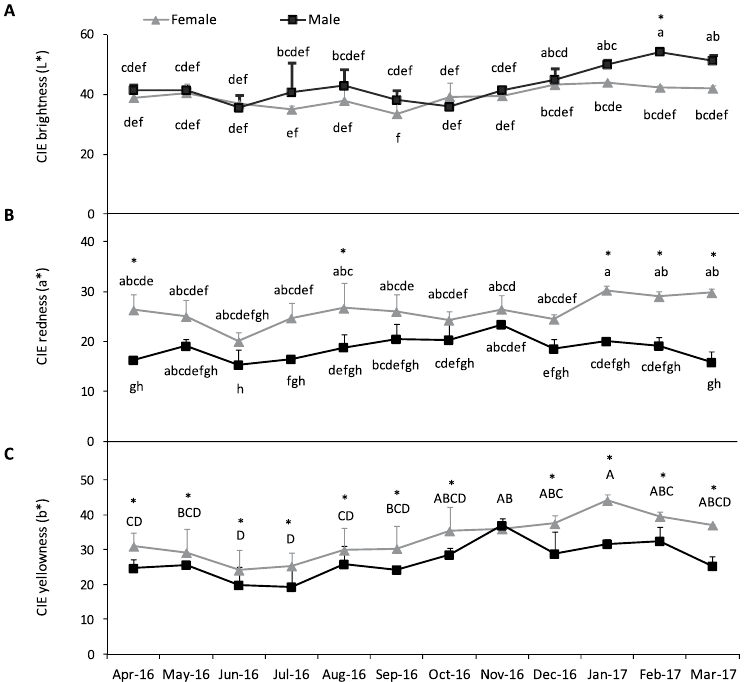
Figure 3. Colour parameters ( A ) lightness, L * ( B ) redness, a * and ( C ) yellowness, b * measured instrumentally in gonads of P . lividus (ovary and testis) over a 13-month period. Values are mean ± standard deviation; per month the 18 individuals were pooled by sex: N = 3 pools of female gonads and N = 3 pools of male gonads were established were established. Superscripts in capital letters ( ABC ) indicate differences between months, asterisk ( * ) indicate differences between sexos and superscripts in lowercase letters indicate significant differences between sex X month ( abc ) (P < 0.05).